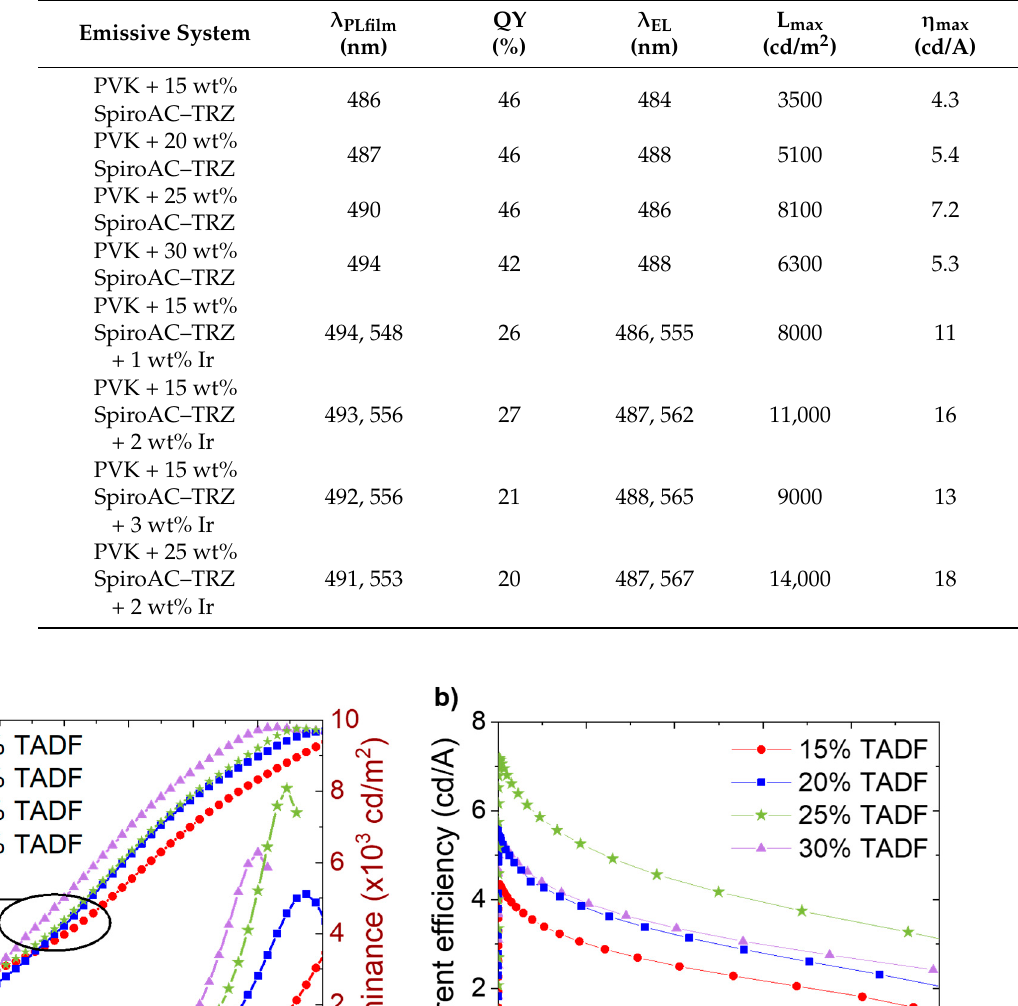
Table 1. Photophysical parameters of emissive layers of PVK with different SpiroAC–TRZ (thermally activated delayed fluorescence (TADF) assistant dopant) and Ir concentrations as well as organic light emitting diodes (OLED) parameters based on such systems. OLED configuration: ITO/PEDOT:PSS